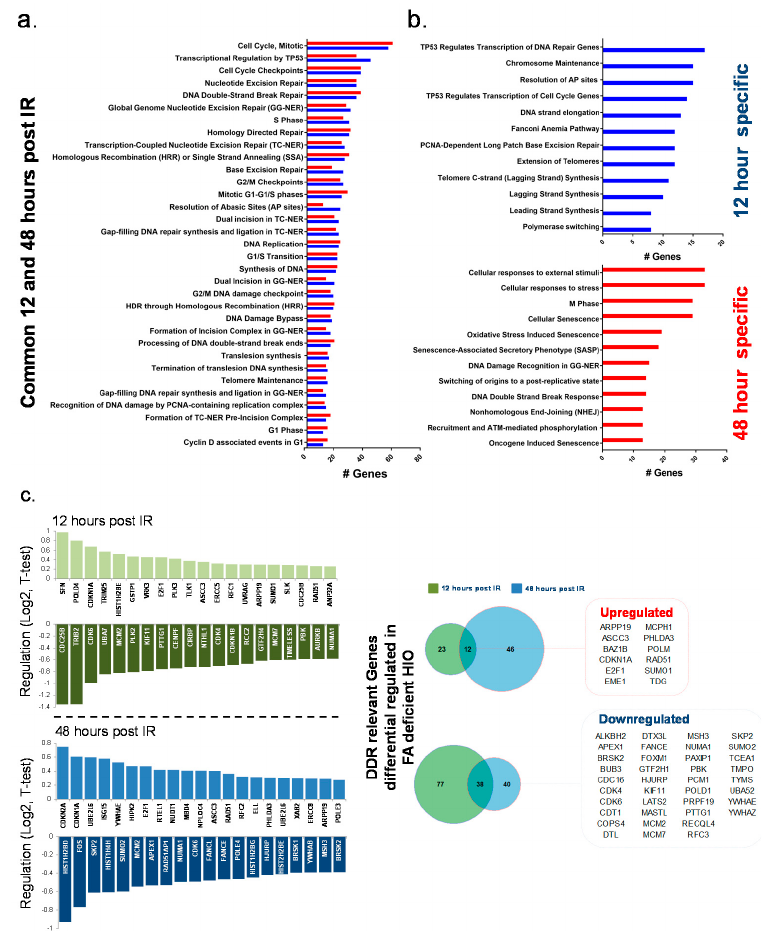
Figure 3. Differential expression of DNA damage response-related genes between wild type